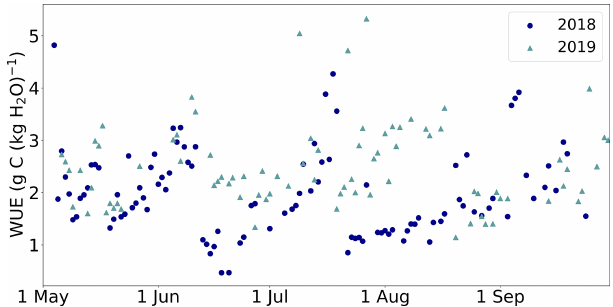
Figure 6. Daily water use efficiency (WUE) during two growing